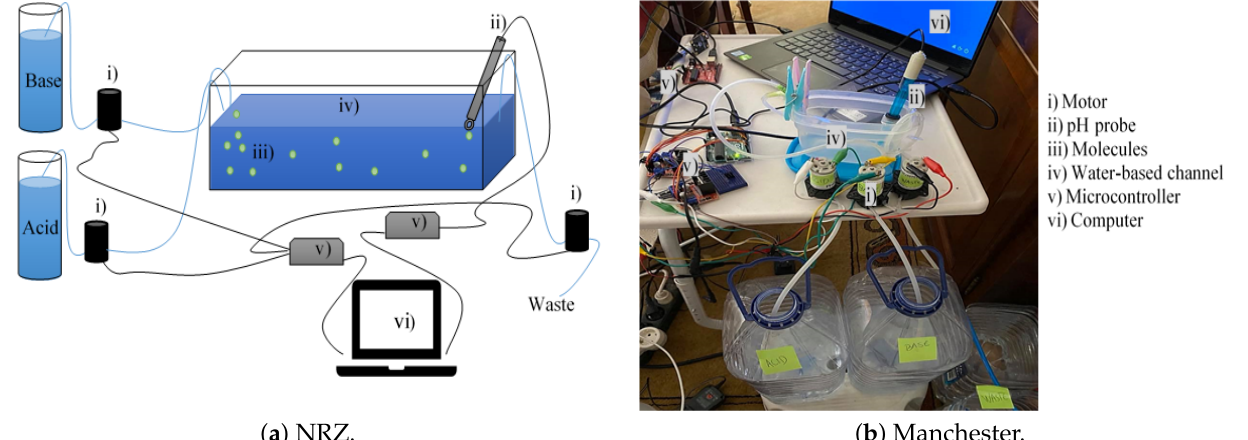
Figure 5. ( a ) Schematic diagram of the experimental implementation. ( b ) Photo of the